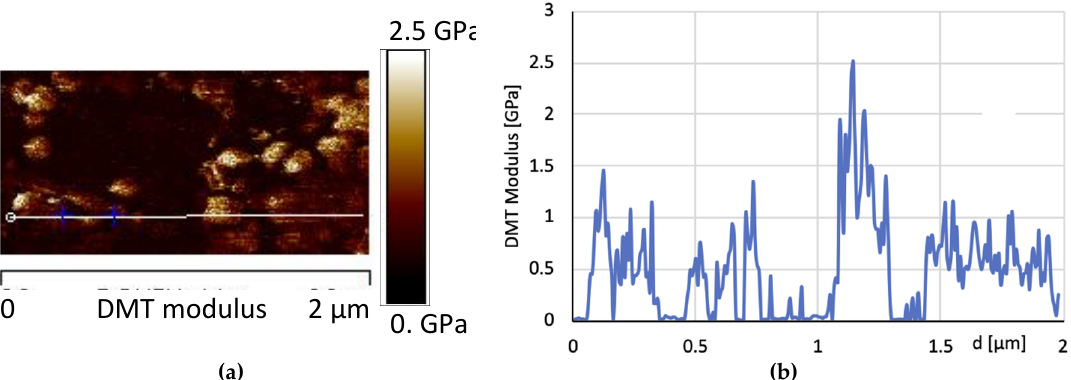
Figure 15. ( a ) AFM image of the DMT modulus maps of the sample 0GNPs (550) with the profile ( b ) of the value of the elastic modulus (elastic modulus scale of the sample taken along the white line).